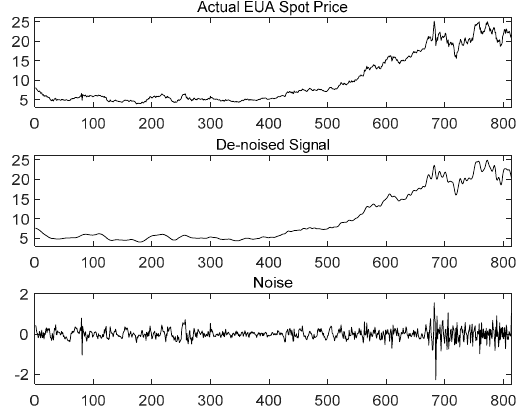
Figure 8. Decomposed results of EUA spot price by MRSVD.